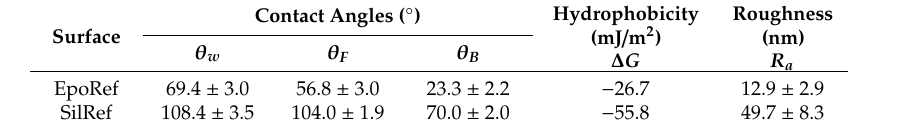
Table 1. Contact angles with water ( θ w ), formamide ( θ F ) and ɑ -bromonaphthalene ( θ B ), hydrophobicity ( ∆ G ) and roughness ( R a ) determined for the SilRef and EpoRef surfaces. Values are presented as means ± standard deviations.